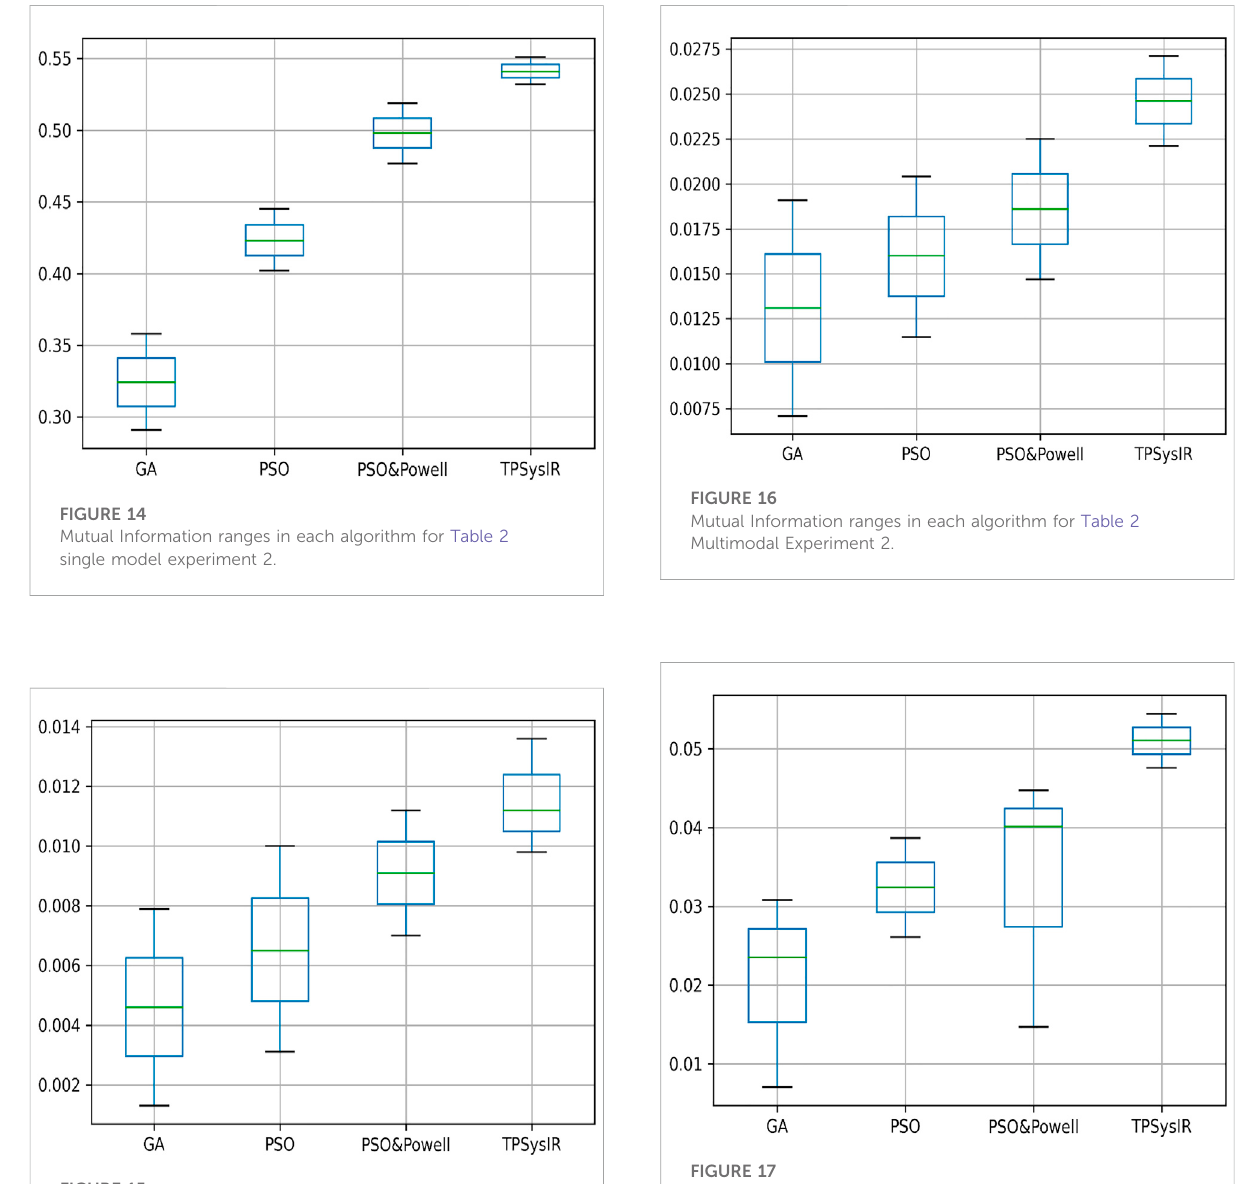
FIGURE 17 Mutual Information ranges in each algorithm for Table 2 Multimodal Experiment